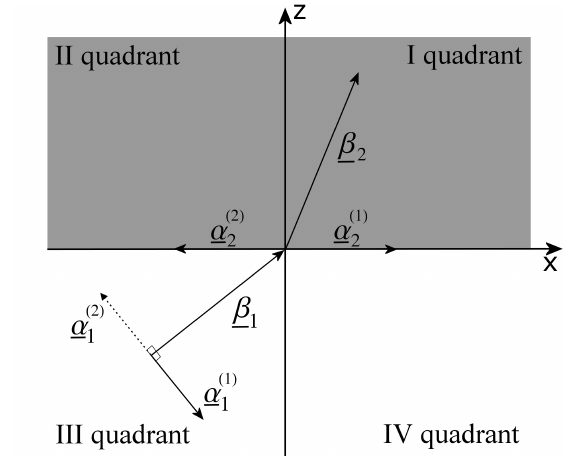
Figure 3. Proper and improper inhomogeneous waves at the interface between a lossless medium and a lossy